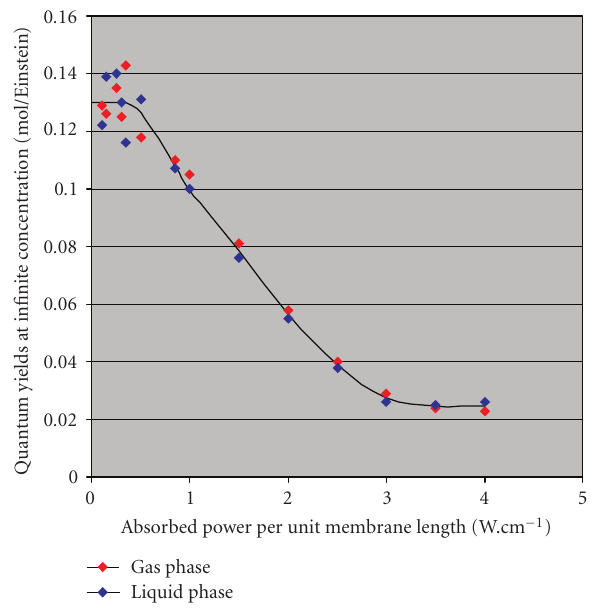
Figure 4: Quantum e ffi ciencies Φ ∞ (mol/Einstein), extrapolated by (14) (see Experimental), at infinite concentration of substrate, for methane in air (red dots) and in aqueous solution (blue dots), as a function of absorbed power per unit length of irradiated photocat- alytic membrane, expressed asW · cm − 1 . Photocatalytic membranes used in the relative experiments did not contain any photopromot- ing